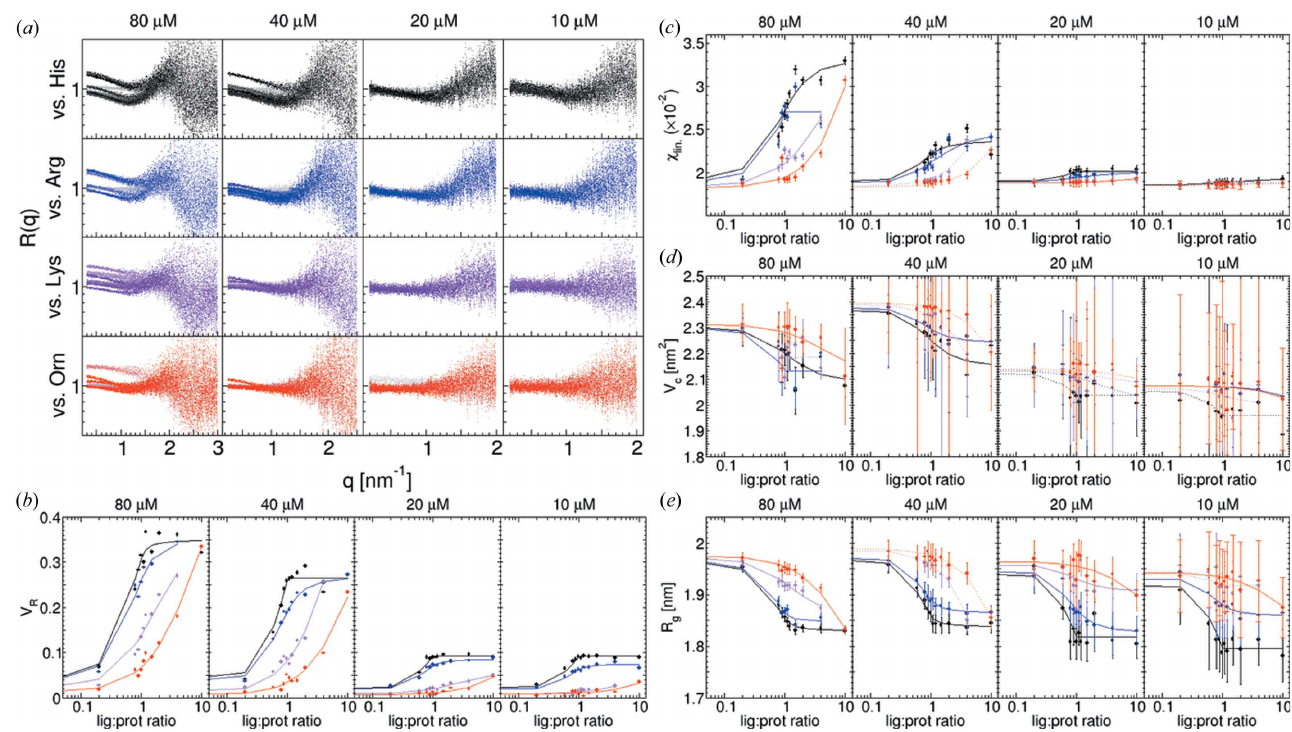
Figure 3 Detailed analysis of HisBP ligand screening at Diamond B21 at four concentrations between 10 and 80 m M . Colours represent HisBP titrated against four ligands: His (black), Arg (blue), Lys (violet) and Orn (red). ( a ) R ( q ) plotted over the q -range included in the analysis. ( b ) Computed V R curves. ( c ) Computed (cid:5) lin curves. ( d ) Computed V c curves. ( e ) Computed R g